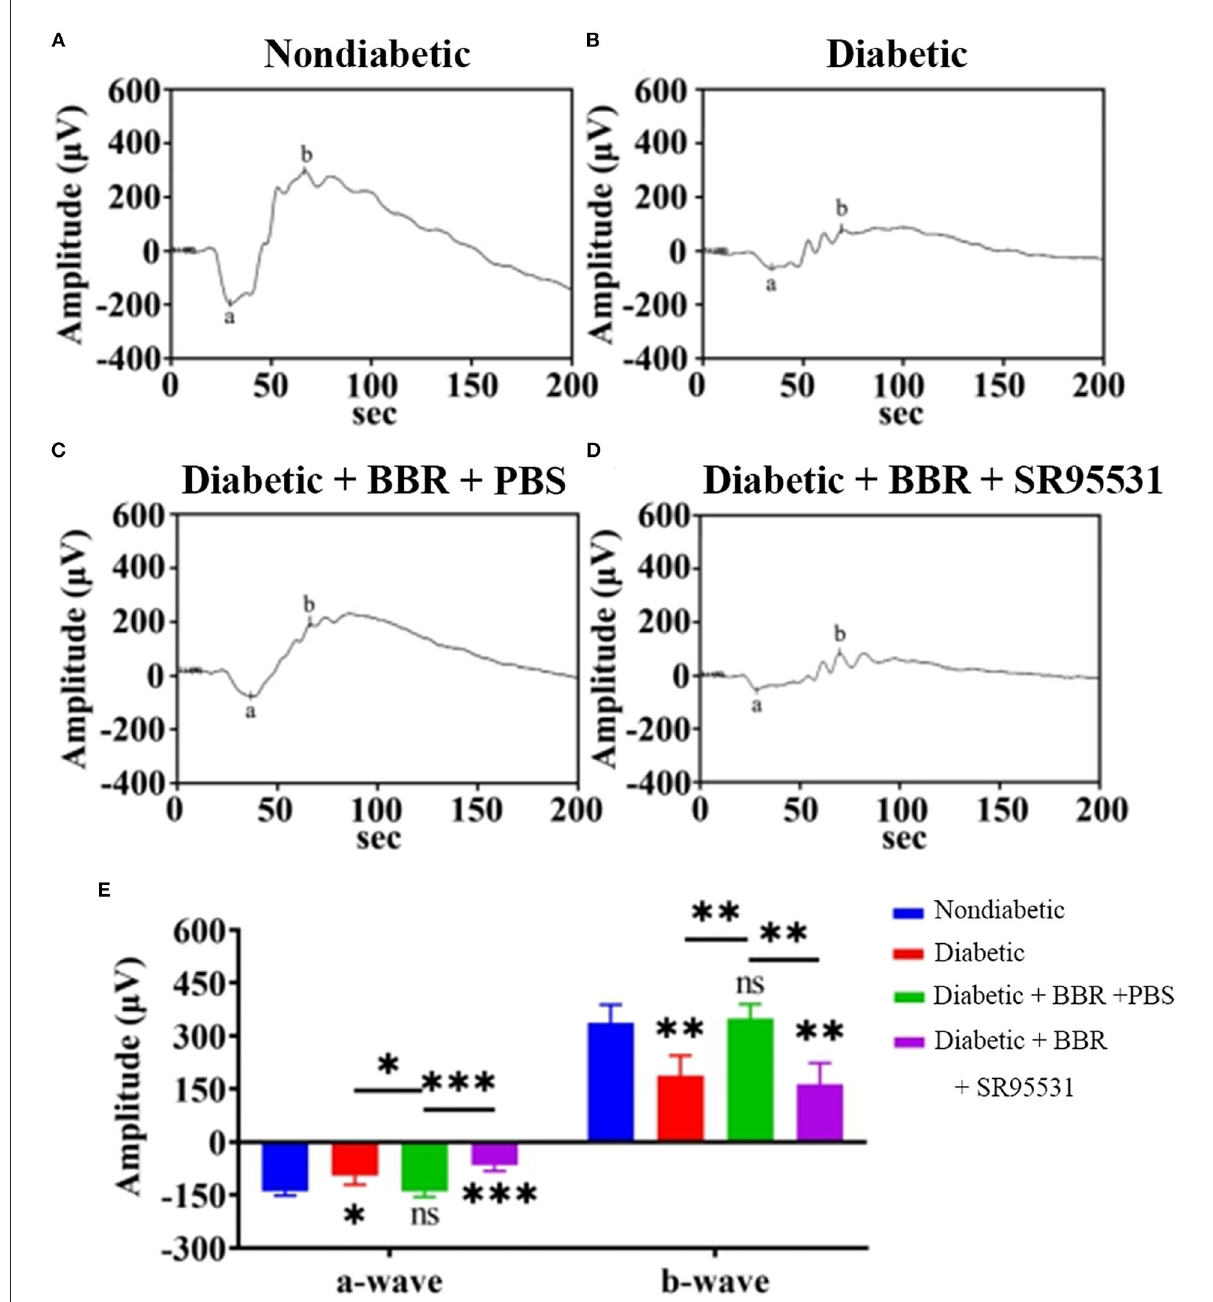
FIGURE8 Representative ERG traces in all experimental groups. (A) Representative traces of the a-wave and the b-wave of a control eye of the non-diabetic group at step 7 in the presence of a scotopic-adapted 3.0-Hz stimulus. (B) Representative waves from the eye of a rat in the diabetic group at the same step and in the presence of the same stimulus as in (A) . (C) Representative waves from the eye of a rat in the diabetic + BBR + PBS group at the same step and in the presence of the same stimulus as in (A) . (D) Representative waves from the eye of a rat in the diabetic + BBR + SR95531 group at the same step and in the presence of the same stimulus as in (A) . (E) Quantitative analysis of a- and b-waves ( n = 4; ns, no significant difference; * 0.01 < P < 0.05; ** P < 0.01; *** P < 0.001; one-way ANOVA; BBR,